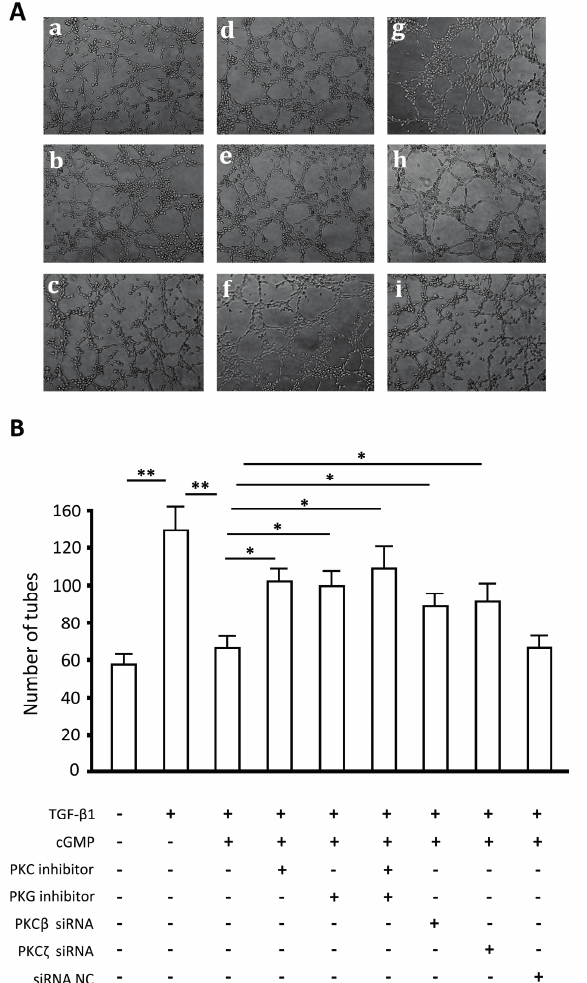
Figure 7. Endothelial tube formation assay. The groups were marked as